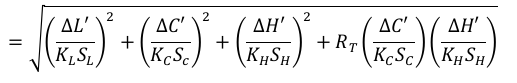
Figure 6. Main effect plot for print density The color variation or deviation in the print is referred to as Delta E. It involves a 3 dimensional color space where each color occupies unique location according to The main effects plot (Figure 6) shows that higher print its color co-ordinates namely L*, a* and b*. The L* density is obtained at higher viscosity, higher anilox refers to lightness and darkness of a color. The a* refers volume, a circular dot shape and on a surface with to green and red coordinates while yellow and blue lower opacity. A lower viscosity (20 sec) implies a coordinates are represented by b* lower concentration of solid content and hence a lower print density was achieved. A lower anilox volume (4.5 BCM) resulted in a lower print density. This occurred due to the fact that a lower anilox volume will store a less amount of ink and therefore will transfer lesser ink and hence a low print density. The dot shape 1 i.e. circular dots exhibited higher print density than square dotted plate. This can be attributed to the fact that area